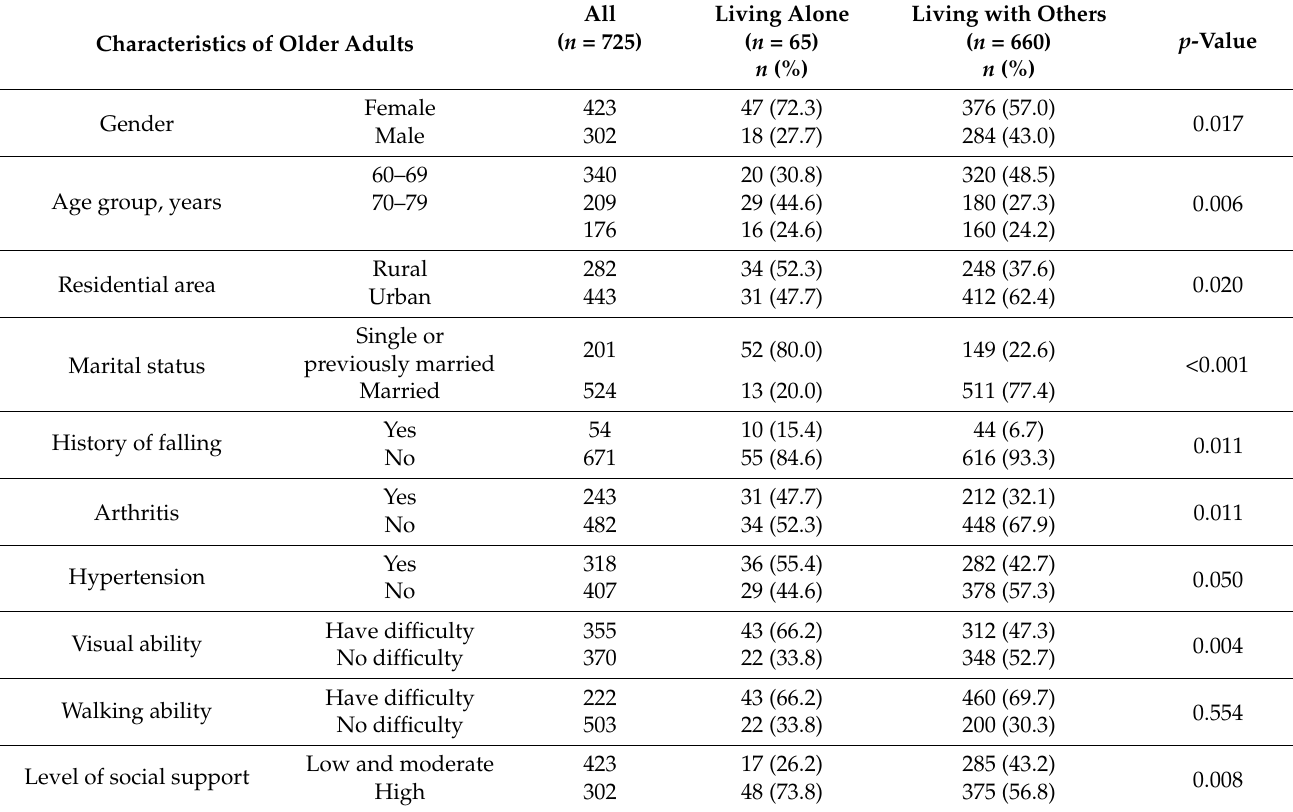
Table 1. Baseline characteristics of older adults according to their living